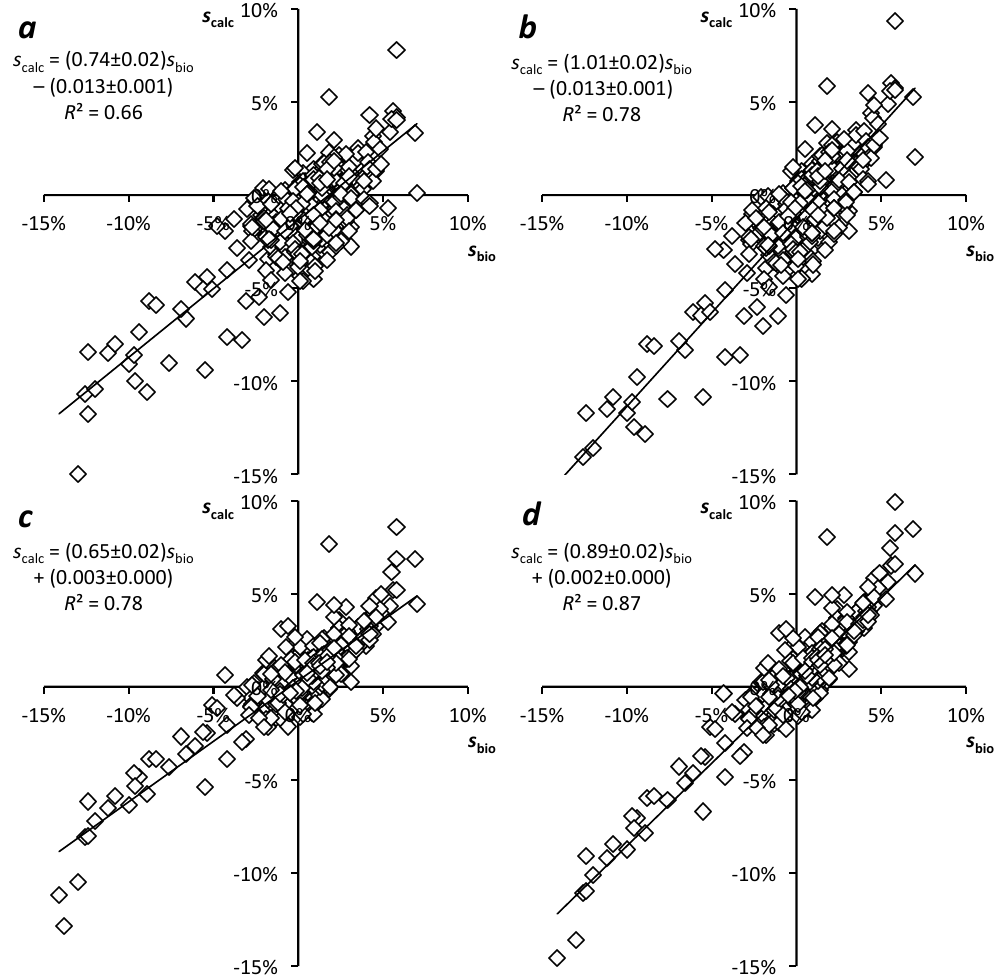
Fig. 5. Comparison between the oxygen supersaturation derived from s calc = gf , with g and f calculated according to Eqs. (48) and (50), respectively, and the biological oxygen supersaturation s bio = 1 (O 2 /Ar) given in Reuer al. (2007). The different panels show the influence of changing different calculation parameters. Panel (a) : 18 ε I =− 2.8‰, 18 ε R =− 20‰. Panel (b) : 18 ε I =− 8.0‰, 18 ε R =− 20‰. Panel (c) : 18 ε I =− 2.8‰, 18 ε R =− 22‰. Panel (d) : 18 ε I =− 8.0‰, 18 ε R =−